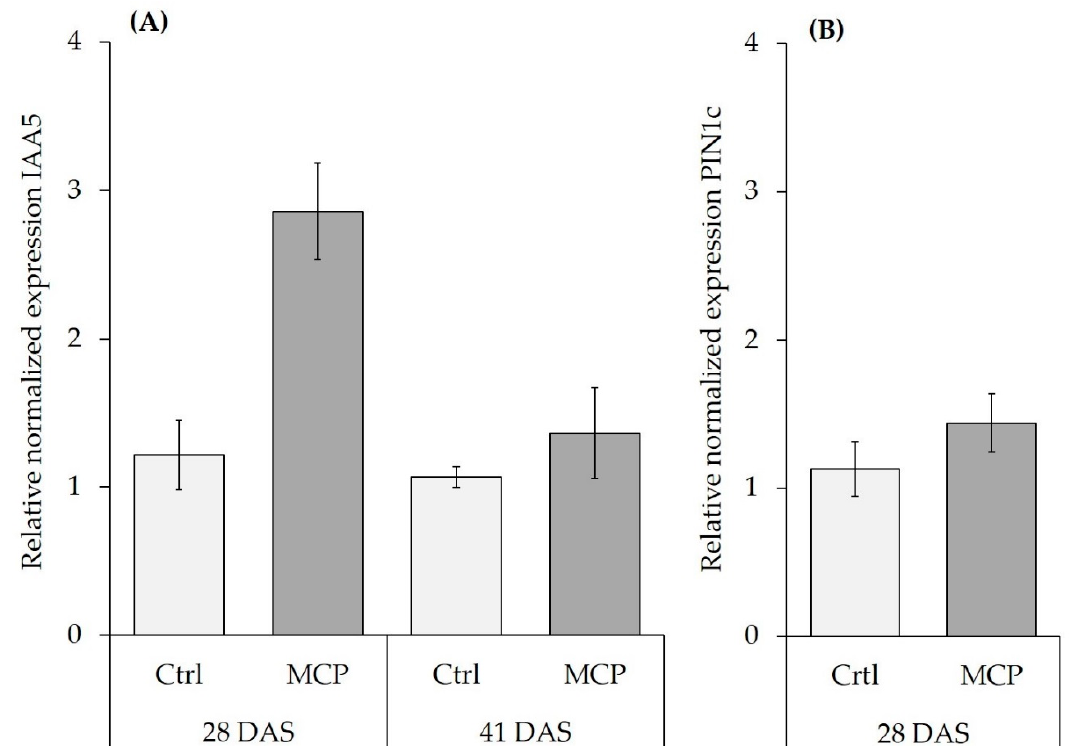
Figure 2. Relative normalized expression of auxin-related genes ZmAux IAA5 (IAA5) and Zm PIN1c (PIN1c) in root tissue of control (Ctrl) and MCP inoculated (MC) maize plants grown on a clay-loam field soil (pH 5.9) with low P availability (Soil 2) supplied with moderate soluble P fertilization (30 mg P kg − 1 ) and N in form of DMPP-stabilized ammonium (NH 4 + ). ( A ) IAA5 expression at 28 and 41 days after sowing (DAS). ( B) PIN1c expression in plants at 28 DAS. Data for IAA5 represent means ± SD of two biological replicates, with nine technical replicates. For PIN1c data represent means ± SD of two biological replicates with three technical repetitions. Table 5. Effect of MCP inoculation on total N min , NO 3 -N [mg kg − 1 soil DM] and NH 4+- N [mg kg − 1 soil